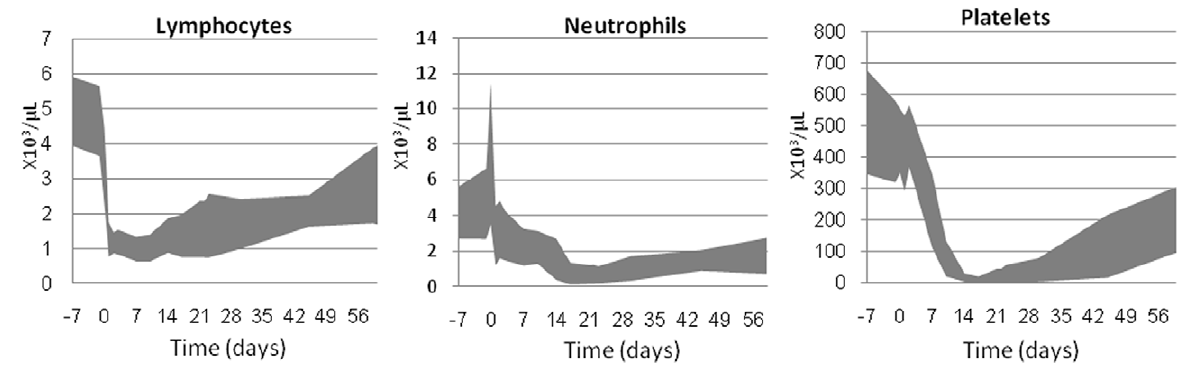
Figure 2. Ranges (min, max) of blood cell loss and recovery in irradiated minipigs. Graphs represent the minimum and maximum blood cell values observed over time from 30 animals irradiated with doses ranging from 1.6 to 2.0 Gy at 0.1 Gy dose intervals and pooled together (6